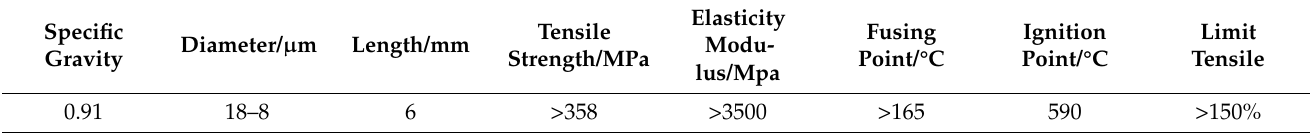
Table 2. Physical and mechanical properties of polypropylene fiber.